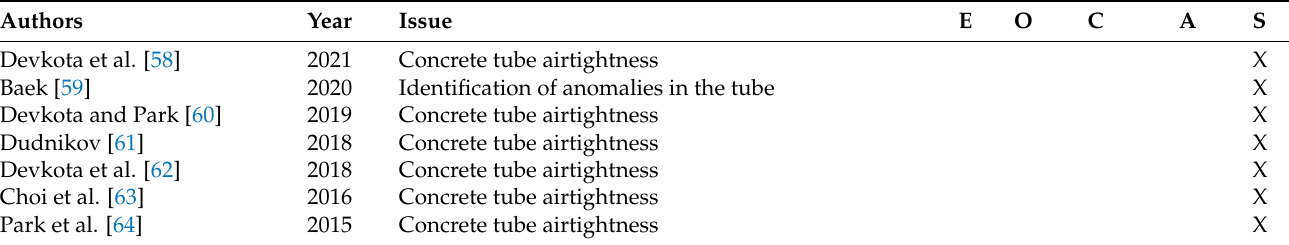
Table 3. Issues identified in research on Hyperloop tube structure.